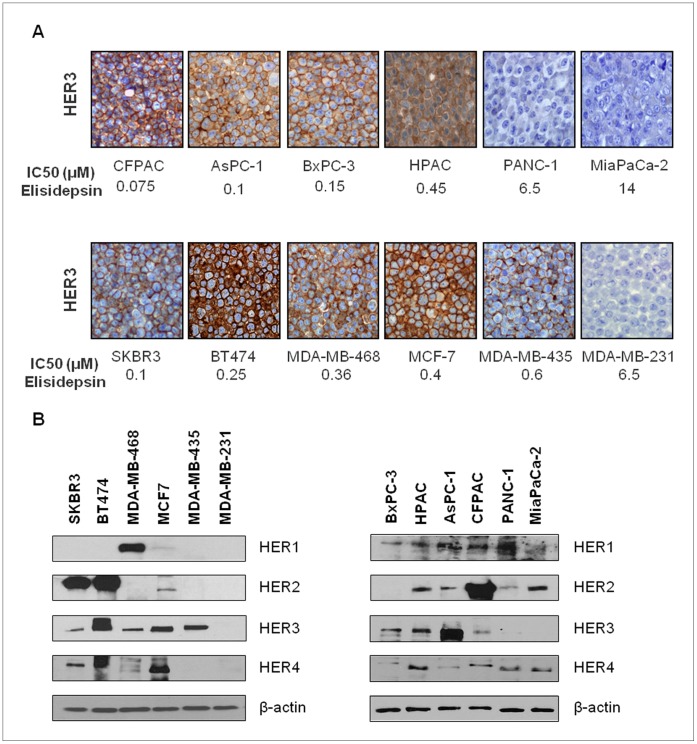
HER3 expression levels correlate with cell sensitivity to elisidepsin.A) Cell pellets were fixed in formalin, embedded in paraffin and a HER3 IHC was performed. Cell lines more sensitive to elisidepsin had significant HER3 levels. Magnification 40x. B) Basal expression levels of HER family members were analyzed by western blot; an association between HER3 expression and elisidepsin sensitivity was observed (Mann-Whitney test: p  = 0.0091; Fig. S3). Cell lines less sensitive to elisidepsin (MDA-MB-231, PANC-1 and MiaPaCa-2) did not show significant HER3 protein levels, while PANC-1 and MiaPaCa-2 cell lines show levels of other HER family members. No correlation was observed with HER1, HER2 and HER4 expression levels (Fig. S3). These protein expression levels were analyzed in duplicate and 50 µg of protein of cell lysate were loaded in each lane.